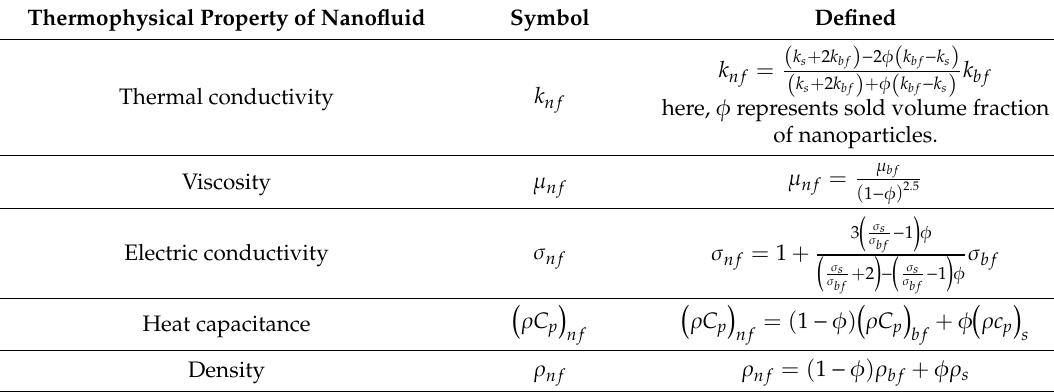
Figure 1. Physical flow model and coordinate system. Table 1. Effective thermophysical properties of nanofluid [47–52].